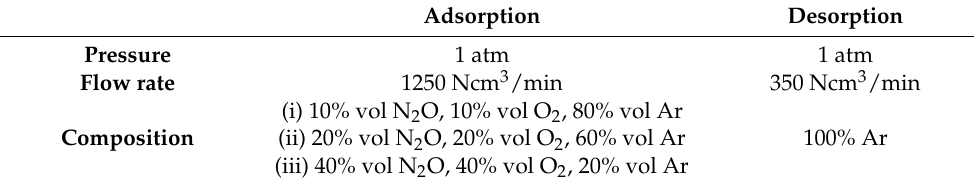
Table 2. Operating conditions of the dry mixture (with O 2 ) in adsorption and desorption.